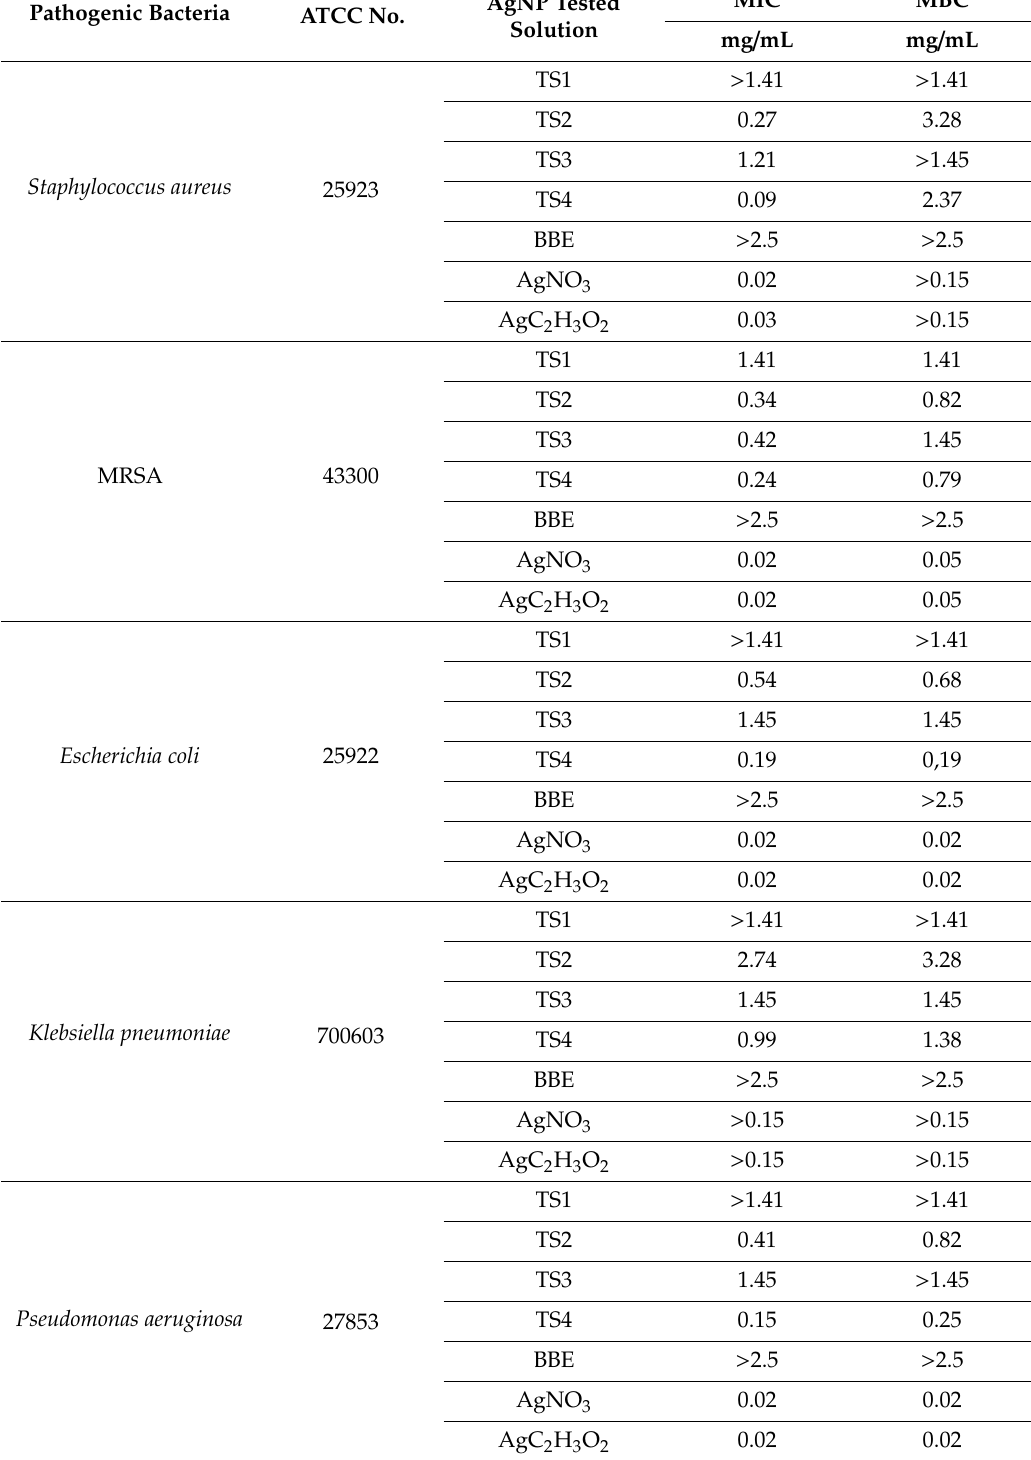
Table 2. Antimicrobial activity of AgNPs against pathogenic bacteria. Pathogenic